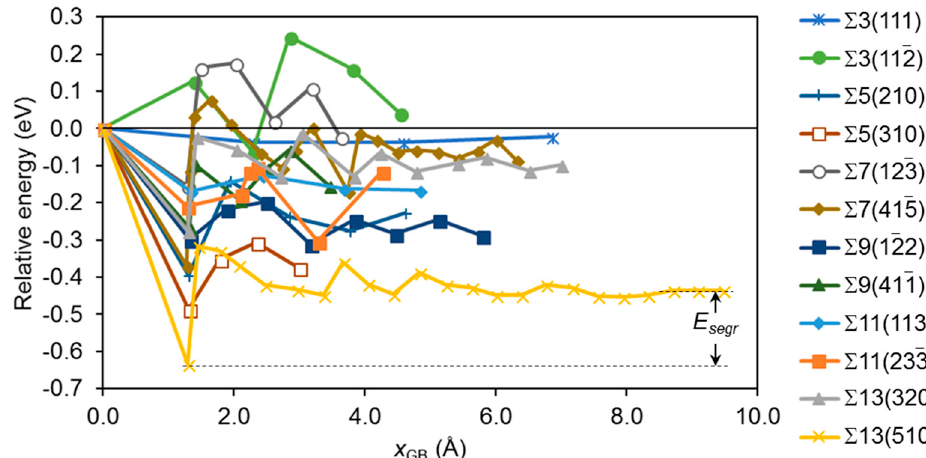
Figure 3. The relative energy E gb in eV of a single Cu impurity Cu Pd as a function of the distance x gb to the plane of the ∑ boundary. The volume relaxation scheme was only relaxation of the x direction. Lines are drawn as guide to the eye. The segregation energy E segr is taken as the difference between the average energy of the three sites furthest away from the GB and the lowest energy among the three nearest sites. The extension of a curve along the x GB axis corresponds to half the size of the unit cell in the x direction. See the text for details.